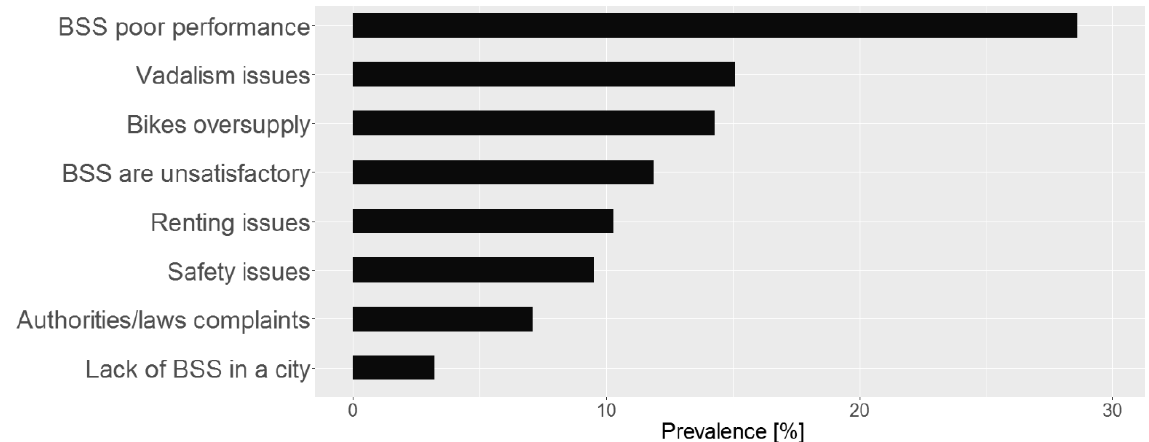
Figure 8. Qualitative topic clusters according to the strongly negative